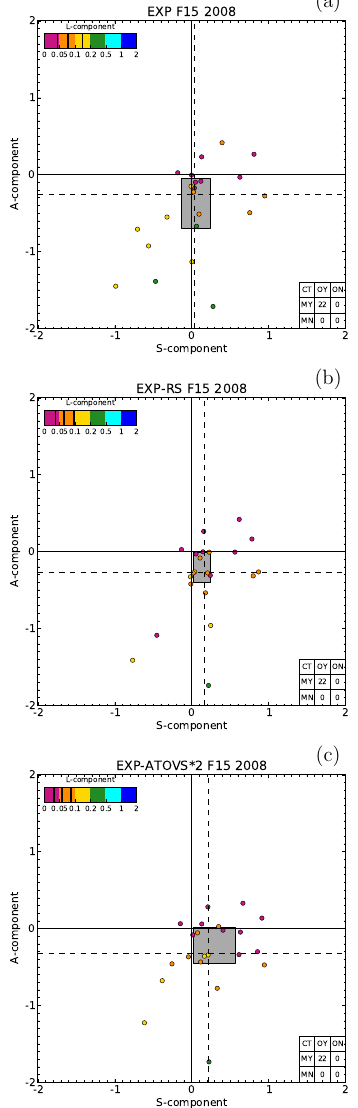
Fig. 9. SAL plots for the three experiments gathering together 2008 and 2009 cases, (a) control (EXP), (b) EXP-RS and (c) EXP- ATOVS*2. Structure S and amplitude A components in x and y axes, respectively, location L in colour scale (legend). Dashed lines depict S and A medians, while the shadowed rectangle comprises the IQRs. Median, percentile 25 and 75 for L are vertical solid black lines in the legend (see text for details).